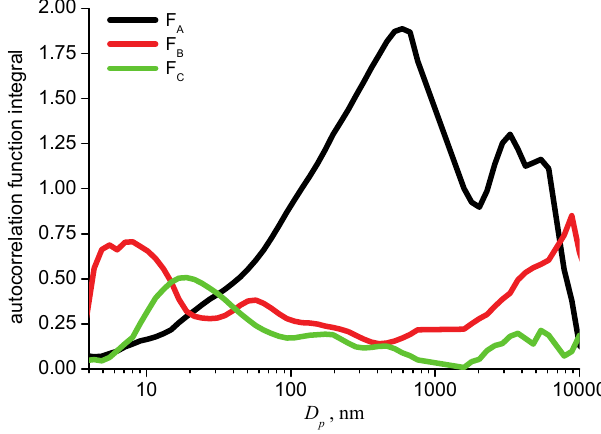
Fig. 7. Integrals of the three auto-correlation function components (0 <t< 14 d) as a function of particle diameter D p . Here, F A is the persistent (long-lasting) component, F B the daily periodical com- ponent and F C the weekly periodical